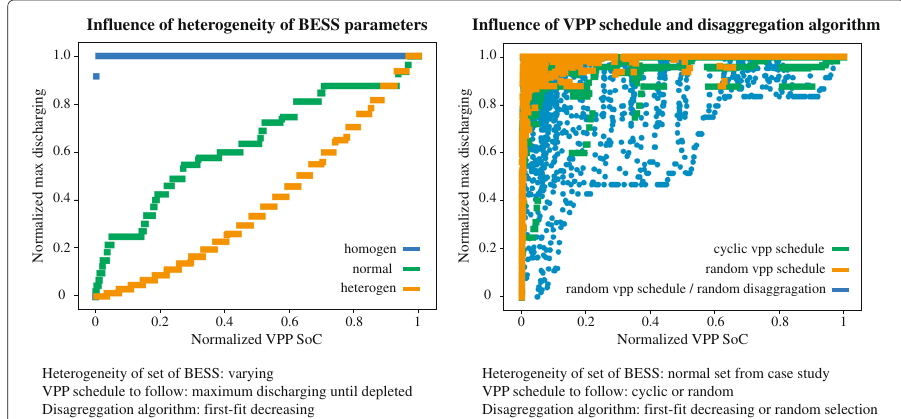
Fig. 1 Analysis of the discharging abilities of the VPP depending on its SoC: One important property of a fleet of BESSs is the relationship of aggregated SoC versus its aggregated charging and discharging abilities. For lower (higher) SoC of the VPP, more individual BESS are fully discharged (charged), and therefore cannot discharge (charge) any further and, thus, the discharging (charging) ability of the VPP reduces. This property depends not only on the BESSs themselves, but also on what is requested from the VPP (VPP schedule) and how this schedule is implemented via the BESS (disaggregation algorithm). The two figures here illustrates this by showing the calculated normalized VPP SoC and its associated maximum discharging ability. The figure on the left varies the heterogeneity of the fleet of BESSs (see also Table 1, that is different distributions of energy content to charging power ratios, while having the same aggregated VPP energy storage size and discharging power). Total number of BESS are 370, with homogenous meaning all BESS being identical, normal a set of BESS from the case study and heterogenous a set with diverse BESS properties. The heterogenous set performs worst since with a maximum discharging schedule all BESS have to contribute and the BESS with high power but small energy content quickly gets depleted. In contrast, the homogenous set can all be discharged uniformly until all BESS are depleted at the same moment. The figure on the right shows the influence for varying VPP schedules and disaggregation algorithms for a normal set of 370 BESSs and one month of operation. The BESS are tried to be operated so that the VPP follows a cyclic or random schedule. Each dot in the figure corresponds to the SoC and discharging situation for one quarter of an hour in this month. Clearly, a more random schedule is beneficial to allow the fleet of BESSs to recover and, thus, provide more discharging flexibility. Further, the first-fit decreasing algorithm achieves a much better exploitation of the abilities of the fleet than a random disaggregation